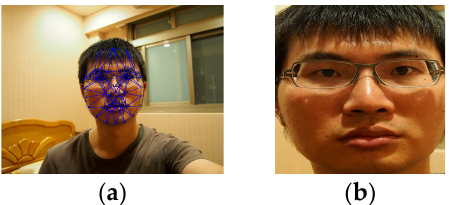
Figure 6. Face image with the region of interest (ROI) being identified and captured by the STASM algorithm. ( a ) Capturing the region of the face with STASM; and ( b ) Converting the image into the resolution of 320 × 320.